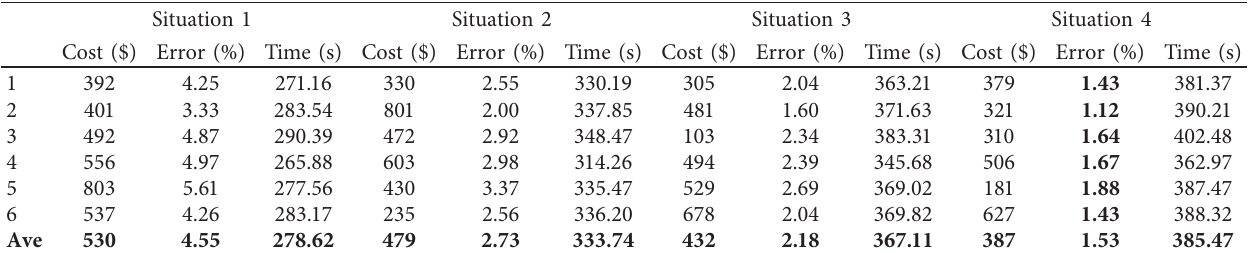
Table 4: The operation results of hybrid evolutionary algorithm in four cases.